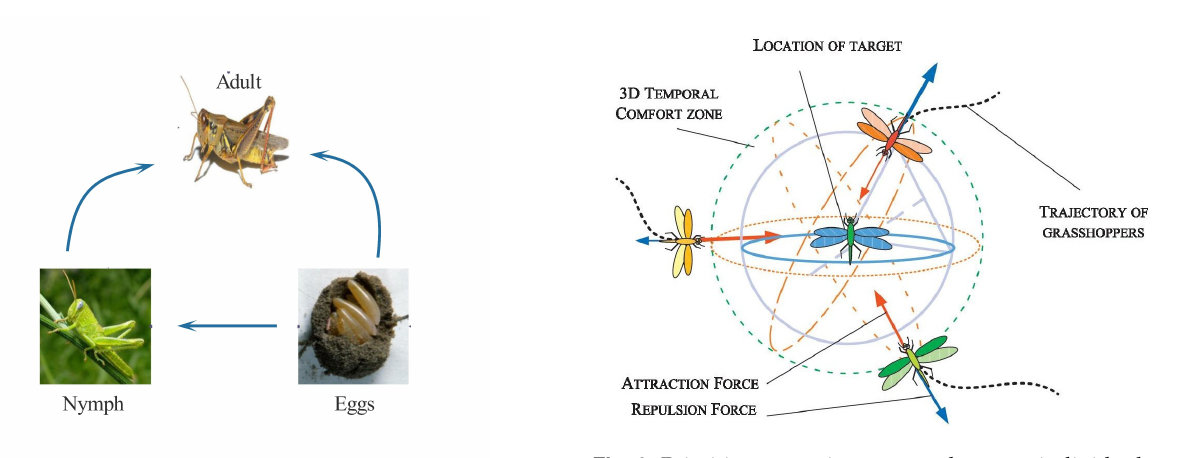
Fig. 6. Primitive corrective patterns between individuals in a swarm grasshoppers